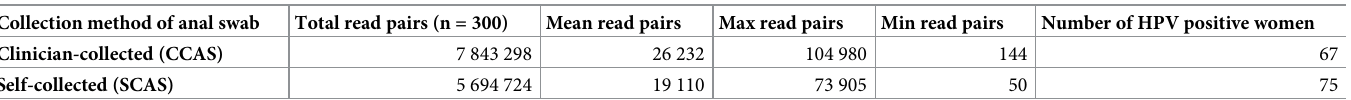
Table 3. Summary of sequence read pairs generated and number of positive clinician-collected (CCAS) and self-collected (SCAS) specimens. Collection method of anal swab